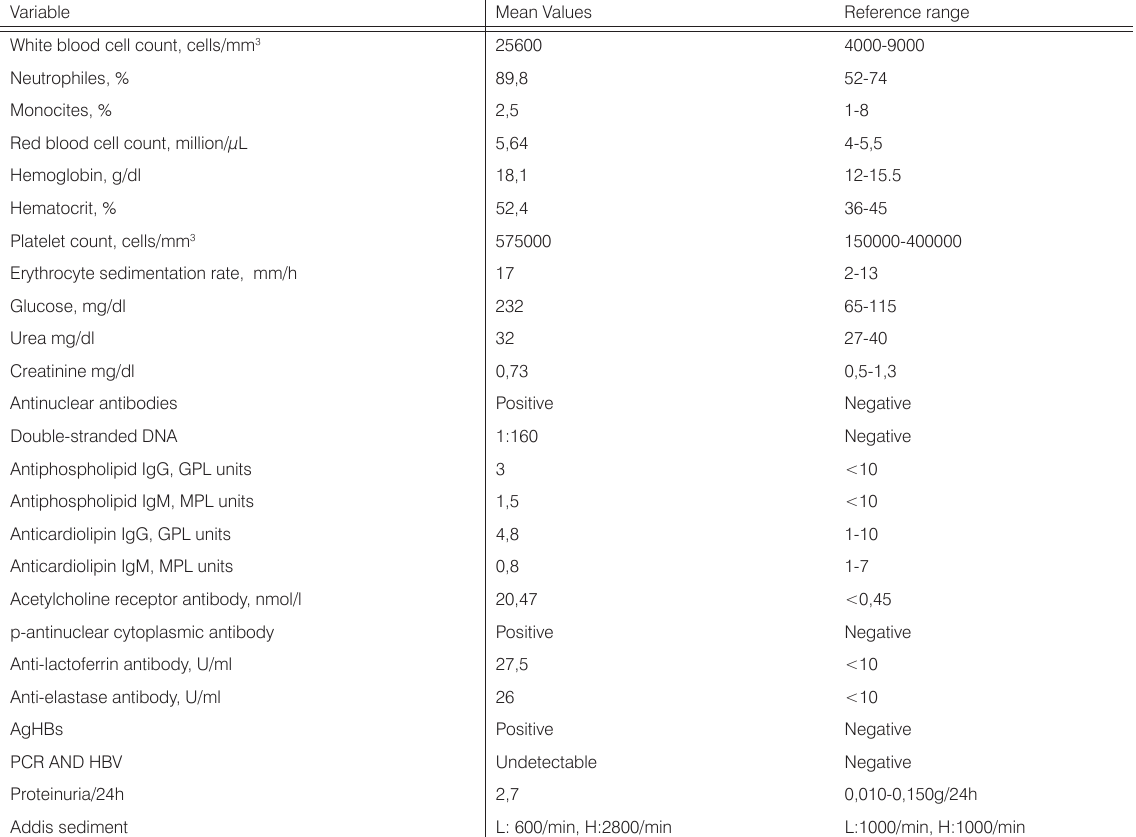
Table 1. Laboratory data on